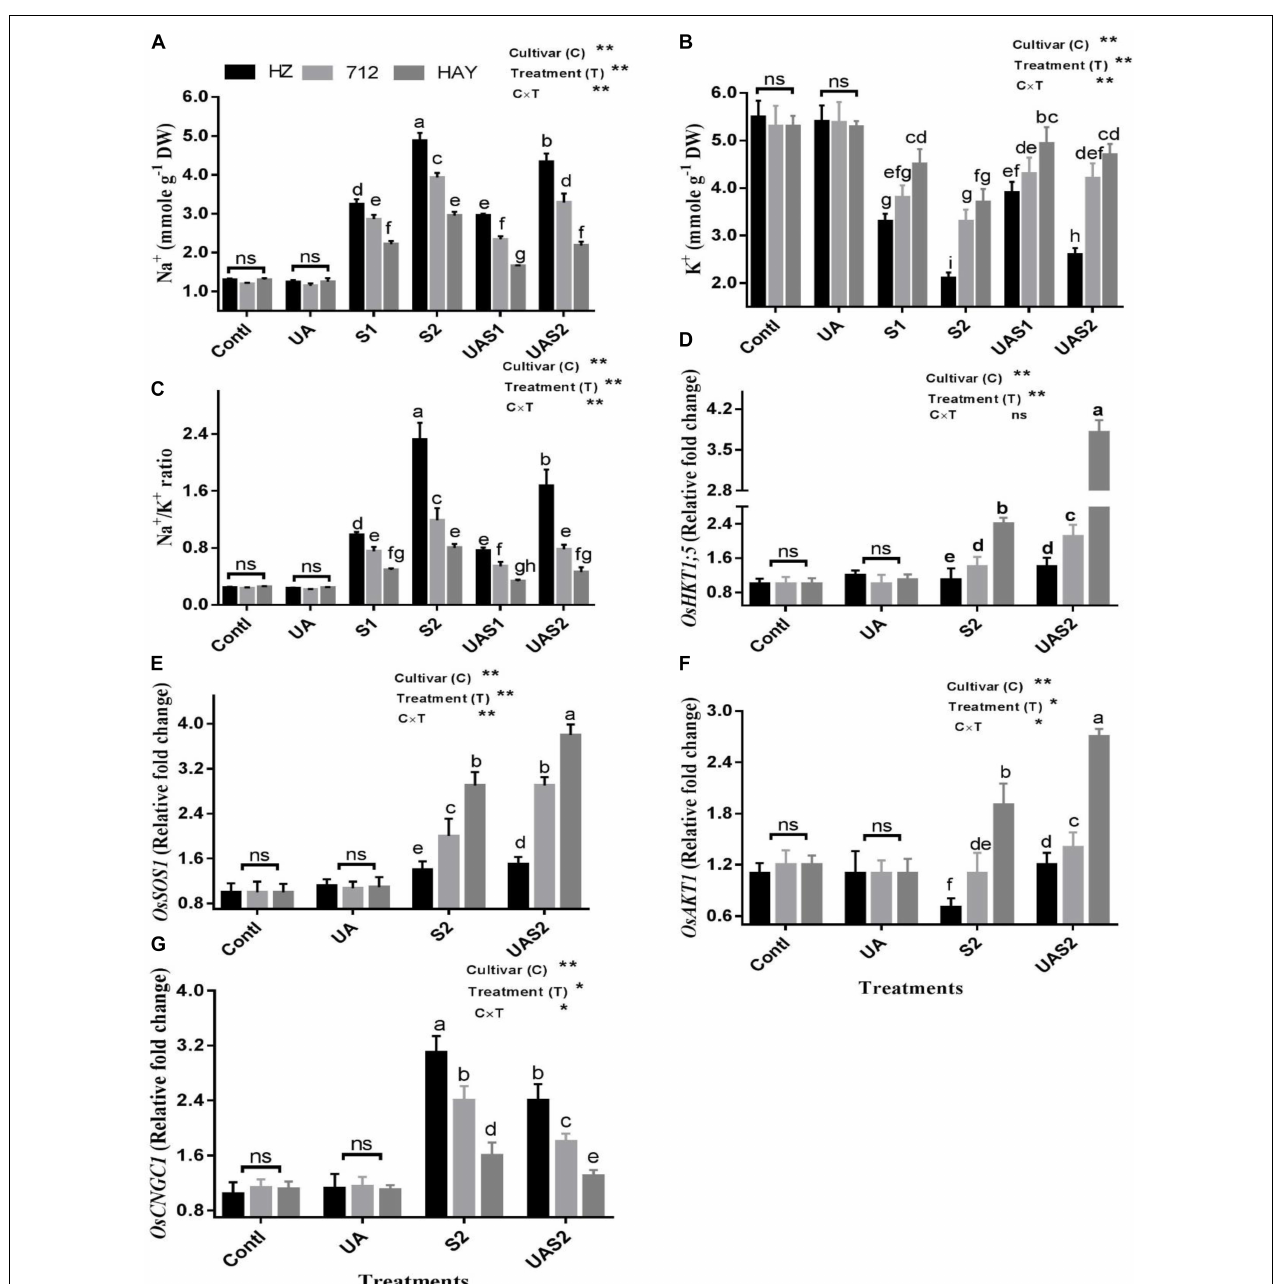
FIGURE 4 | Effect of UA pretreatment on the accumulation of sodium (Na + ) (A) , potassium (K + ) (B) , and Na + /K + ratio (C) in leaves of three rice cultivars under controlled and salt stress conditions. The results are shown the mean ± SE of five replicates and three/four were plants bulked for each replicate. Error bars represent the standard error. Expression of salt transporter genes (D–G) in leaves of three rice cultivars under controlled and salt stress conditions. Transcript levels were determined by qRT-PCR and calculated by 2 − (cid:49) (cid:49) CT using ubiquitin as an endogenous reference and control plant as a calibrator. Means with the same letters are not significantly different based on two-way ANOVA followed by Duncan’s test ( p ≤ 0.05) for each cultivar at different salt stress treatments. The results are shown the mean ± SE of four replicates and three plants were bulked for each replicate. Contl = control, UA- = ursolic acid. S1 = 4 dS m − 1 , S2 = 8 dS m − 1